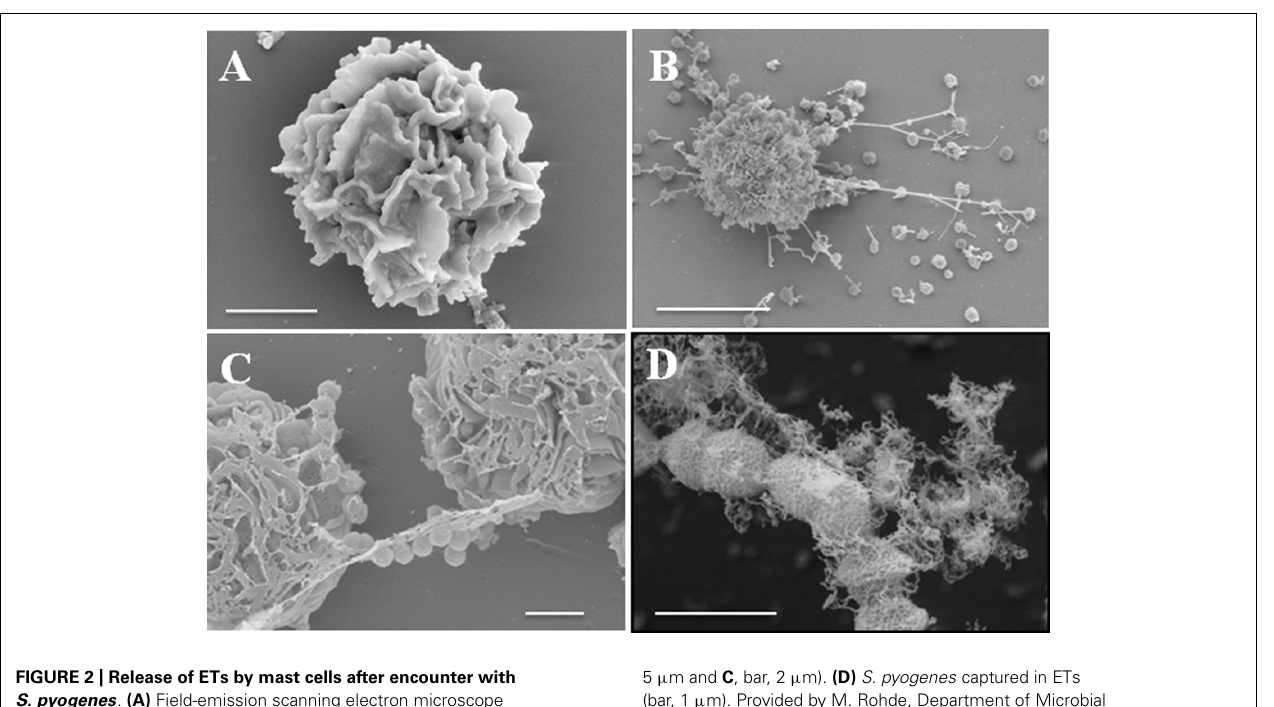
FIGURE 2 | Release of ETs by mast cells after encounter with S. pyogenes . (A) Field-emission scanning electron microscope (FESEM) images of a resting mast cell (bar, 2 μ m). (B,C) Mast cells in the process of releasing ETs in response to S. pyogenes ( B , bar,